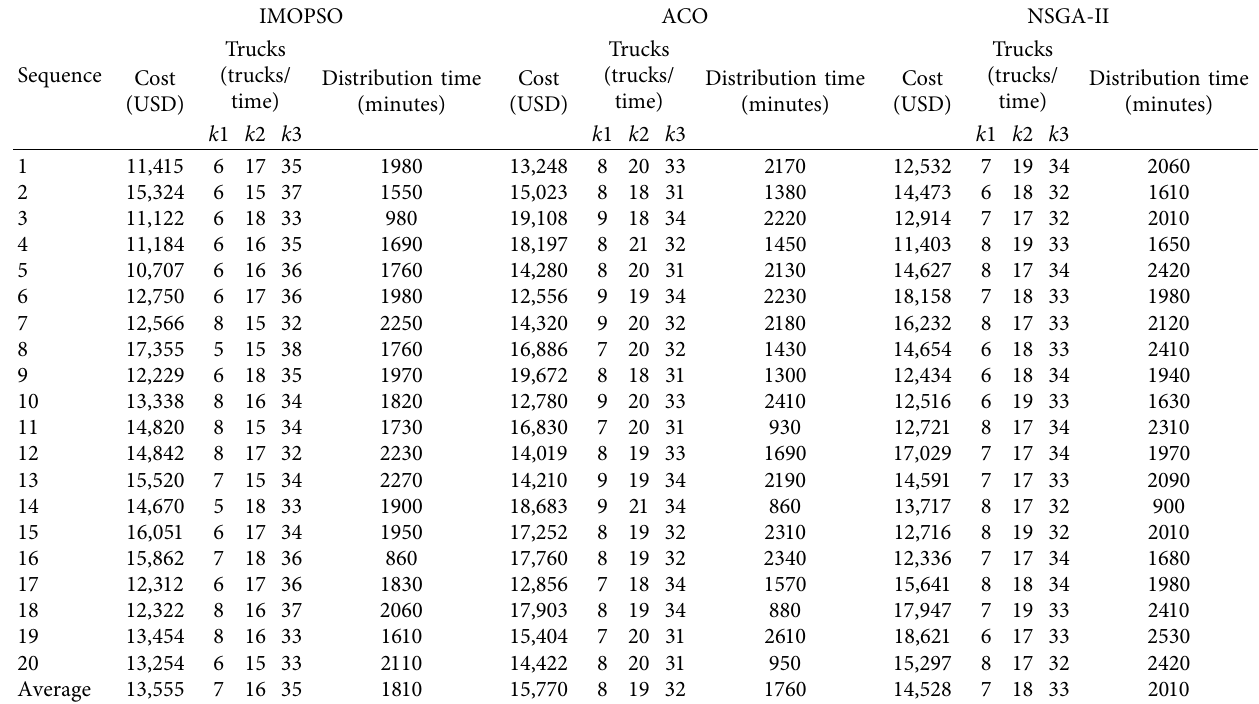
Table 12: Comparison of algorithm